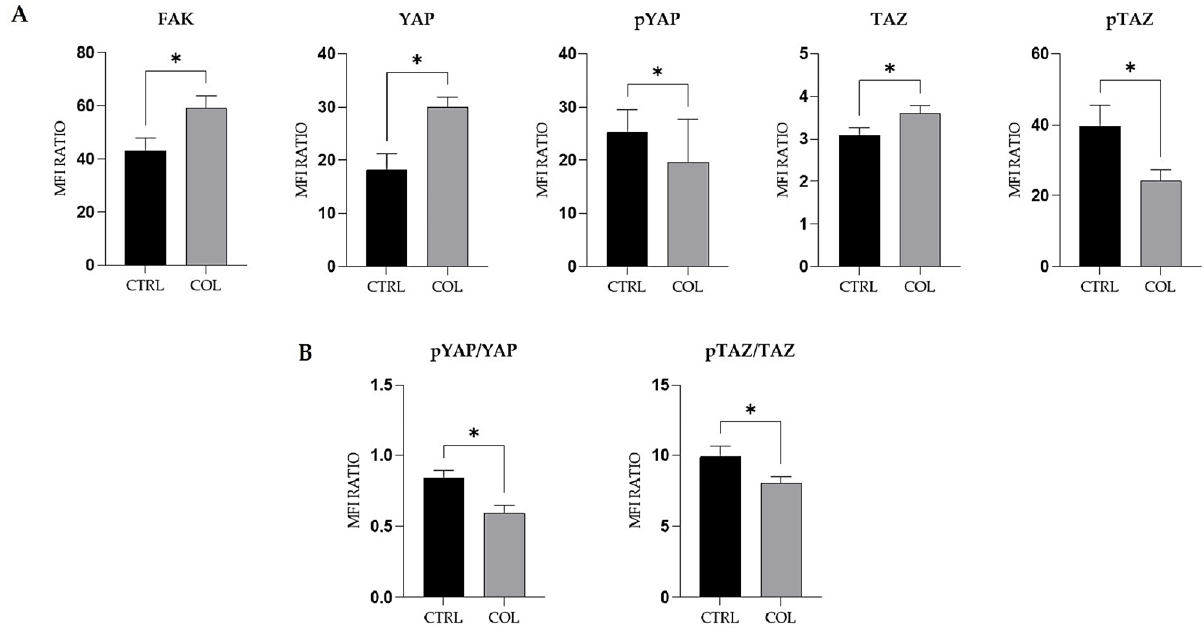
Figure 6. ( A ) Bar graphs of YAP and TAZ activated and inactivated (phosphorylated) forms, and ( B ) pYAP/YAP and pTAZ/TAZ ratios expressed by hGF grown on collagen-coated (COL) or uncoated cell culture plastic substrates (CTRL) after 48 h. Data are expressed as mean ± standard error (n ≥ 3). (* p < 0.05).